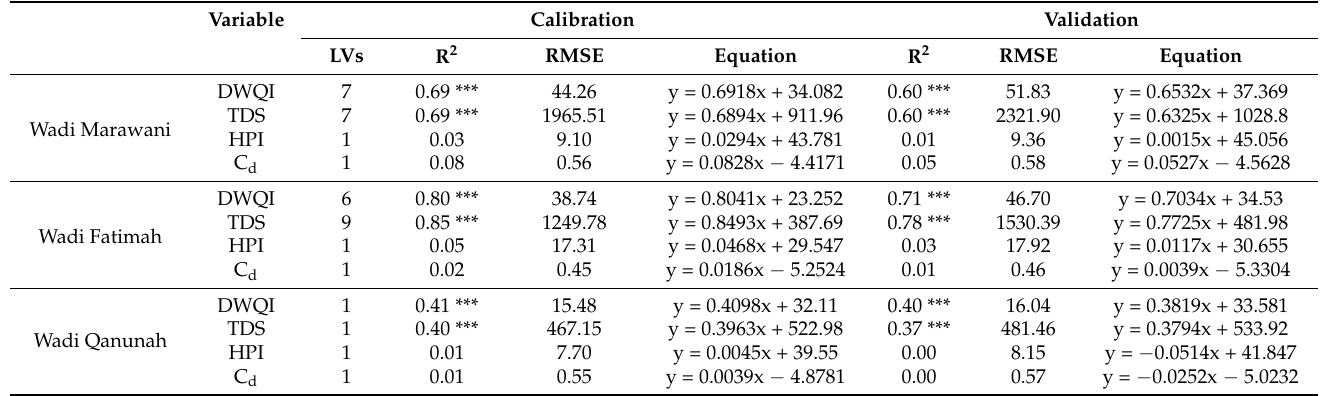
Table 10. Outcomes of calibration and validation models of PCR for the association between observed and predicted values for DWQI, TDS, HPI, and C d of the three wadies. Variable Calibration